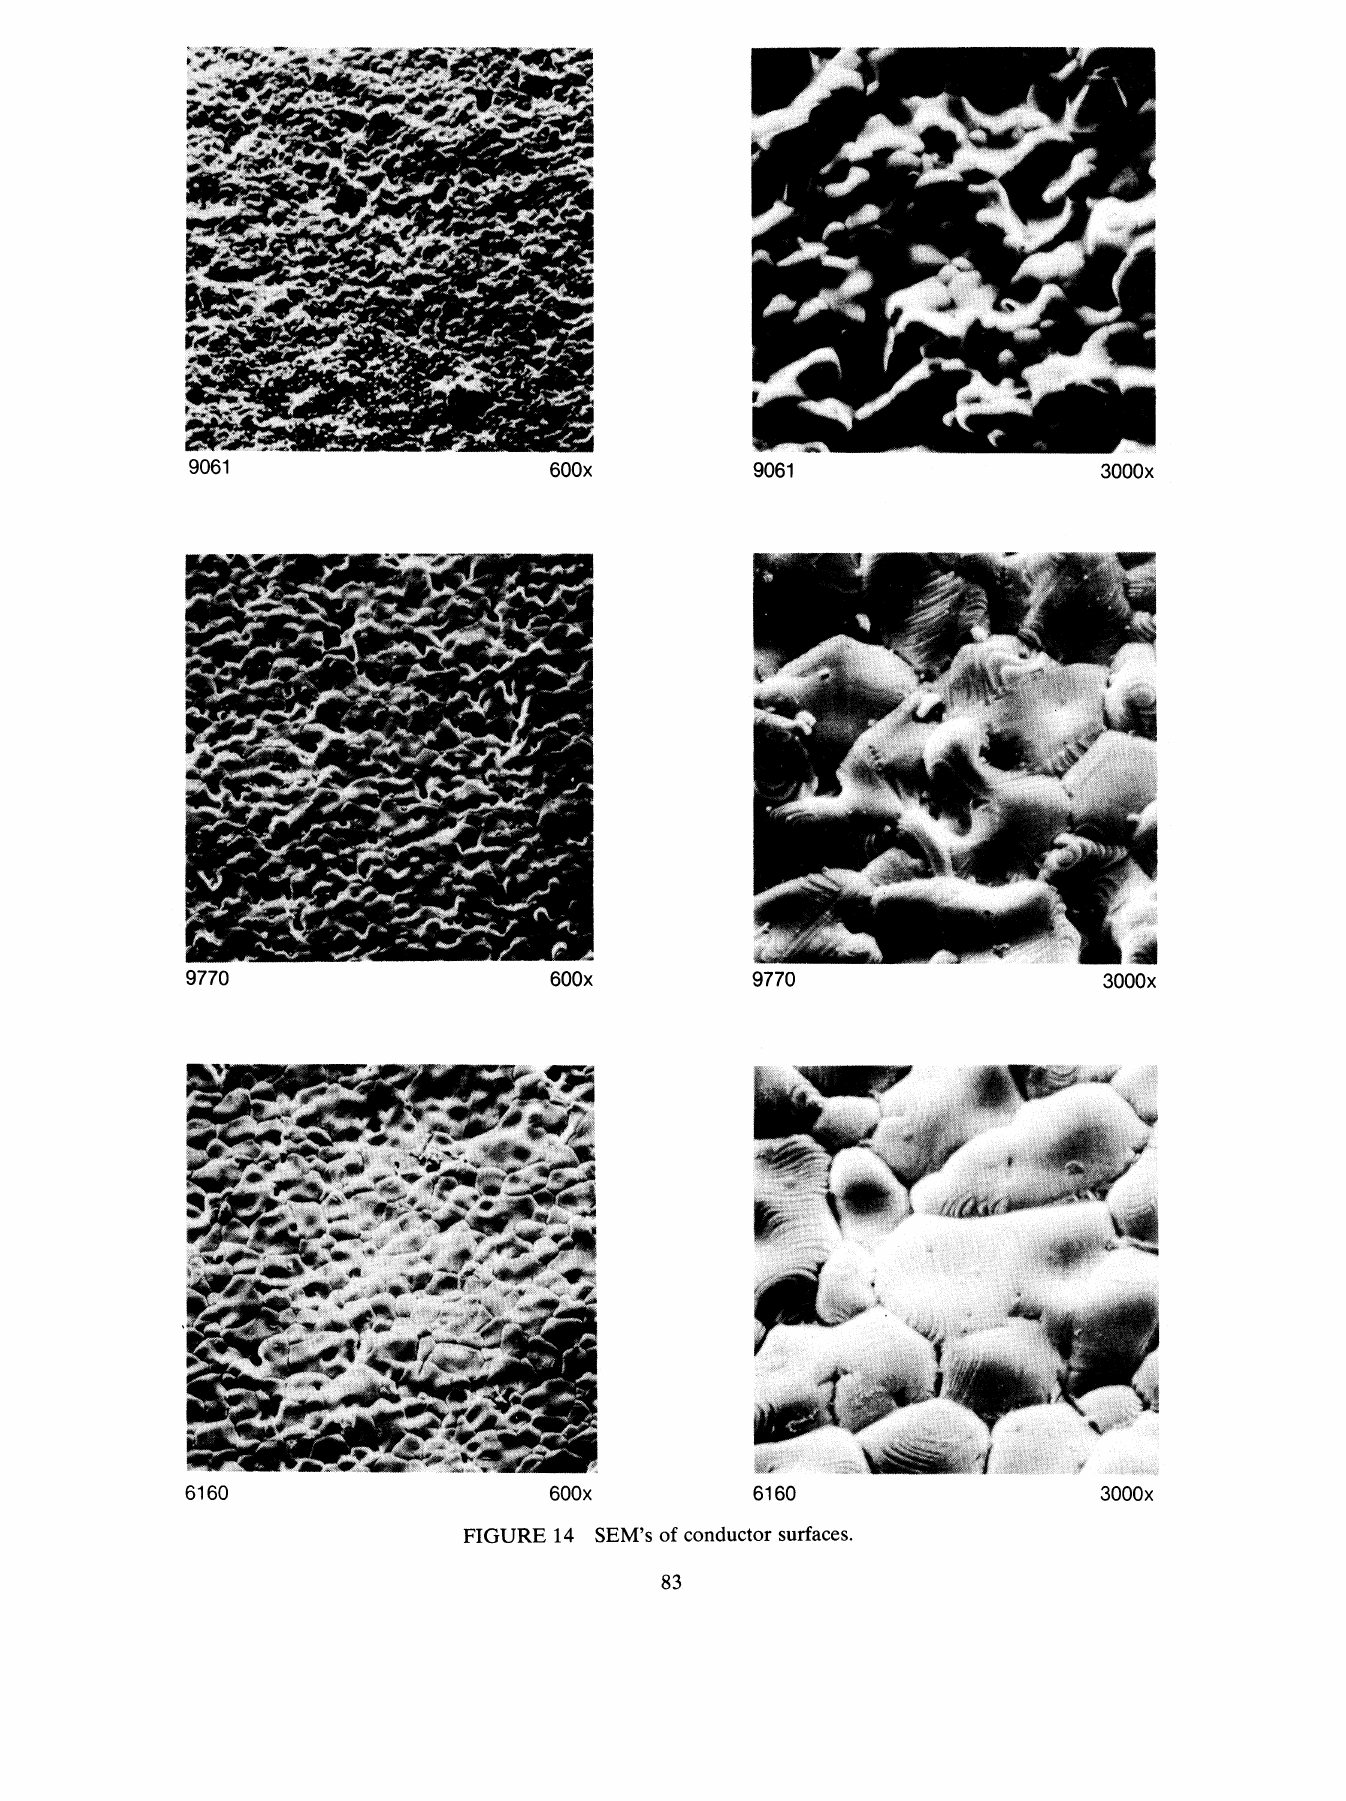
SEM’s of conductor